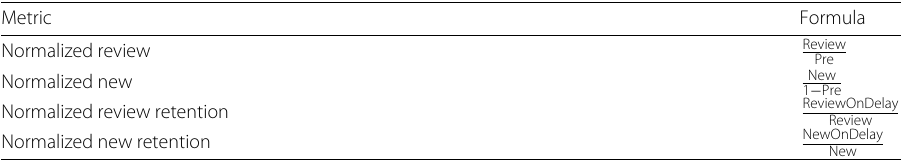
Table 2 Calculated user metrics and their formula Metric